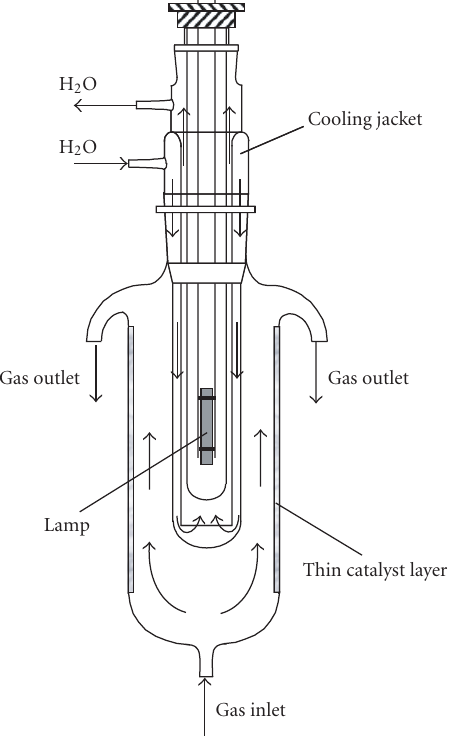
Figure 2: Continuous annular photoreactor for acetonitrile photo- catalytic degradation in gas-solid